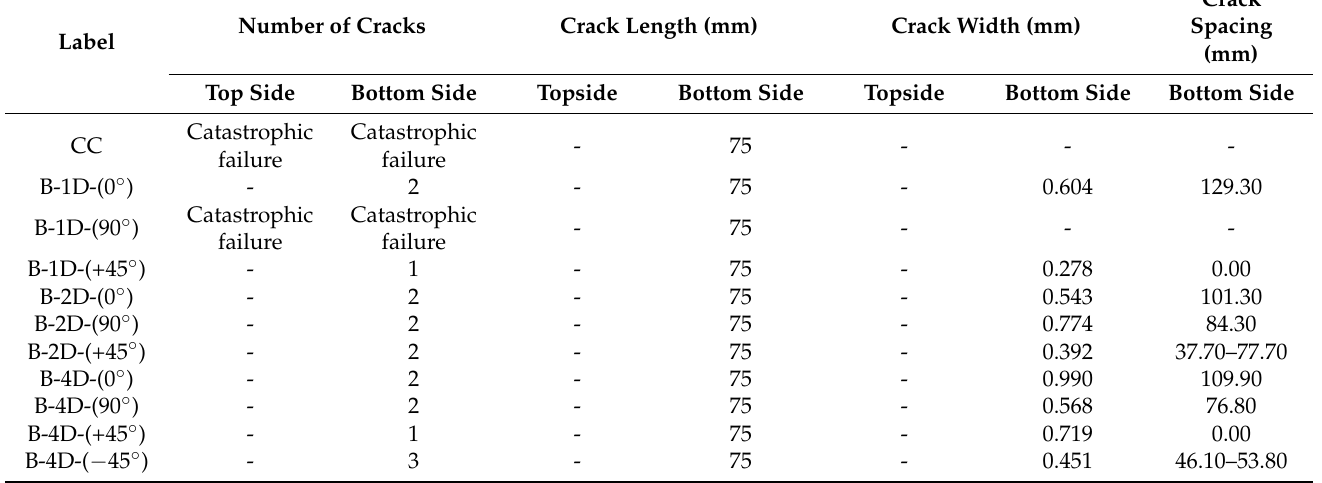
Table 6. Failure results on the multiaxis 3D basalt fiber